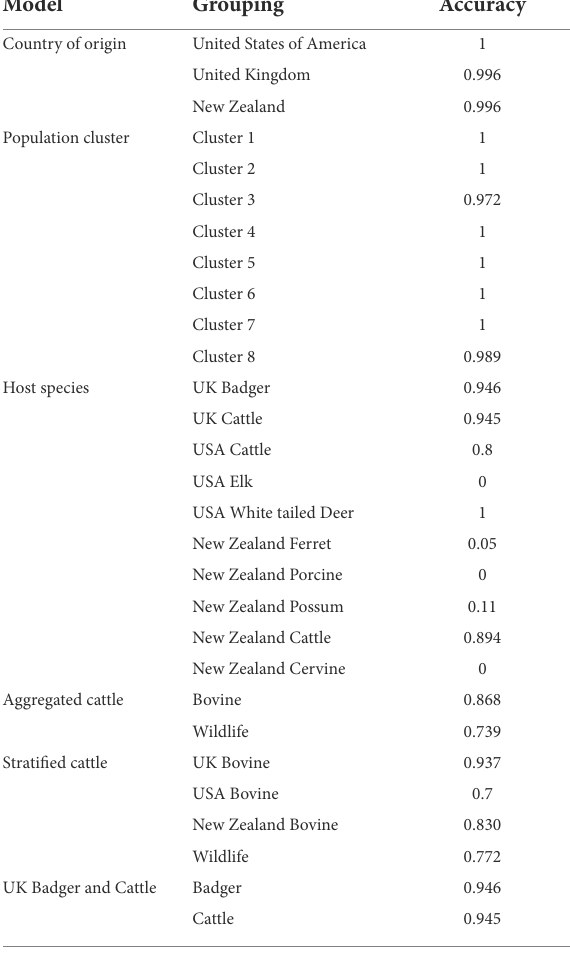
TABLE 1 Summary of the random forest classification accuracy for each developed model.